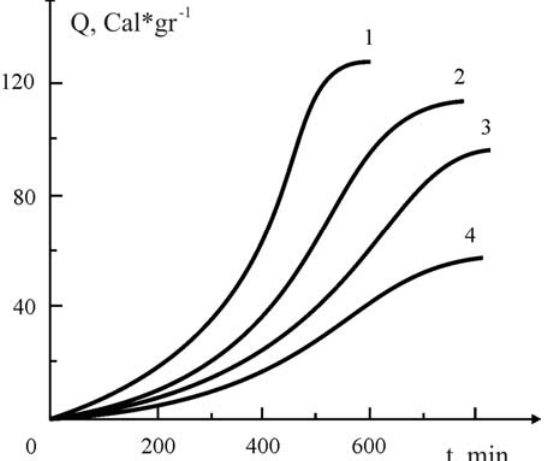
polymerization of MMA under the impact of 3 ⋅ 10 -2 M·L -1 at 60 ° C. Y content (in gr.): 0-(1); 0.1(2); 0.2 (3); 0.3 (4) [19].